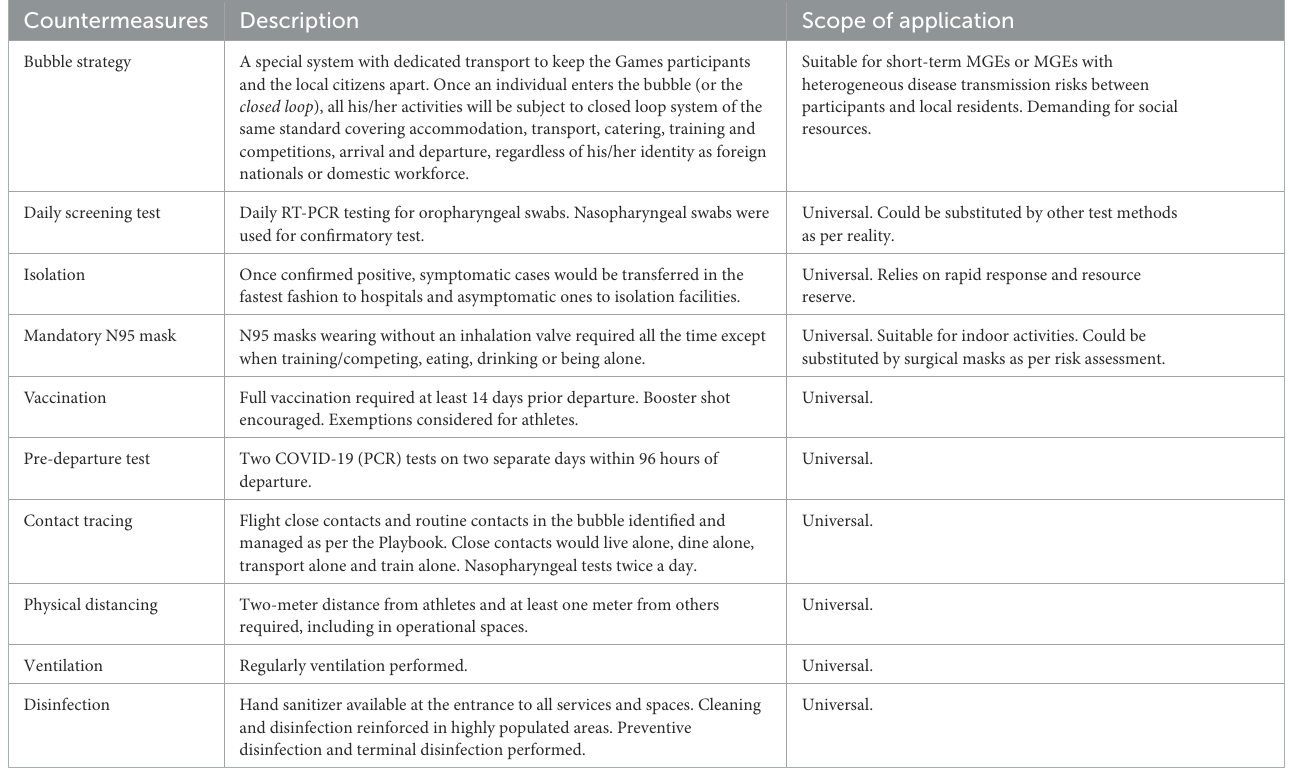
TABLE 1 Primary and supplementary countermeasures implemented in the Beijing 2022 Olympic Winter Games.